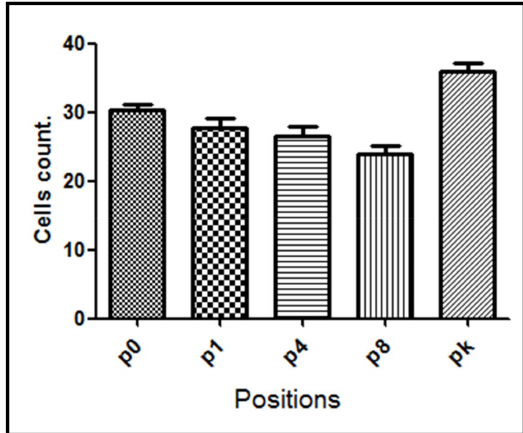
Figure 5. NF- κ B positive cell count for G2 group evaluated at different positions from the bone lesion. The mean number with the corresponding standard deviation is shown for each point.